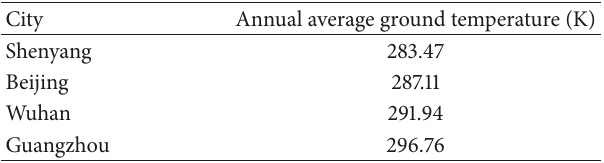
Table 3: Annual average ground temperature of typical cities